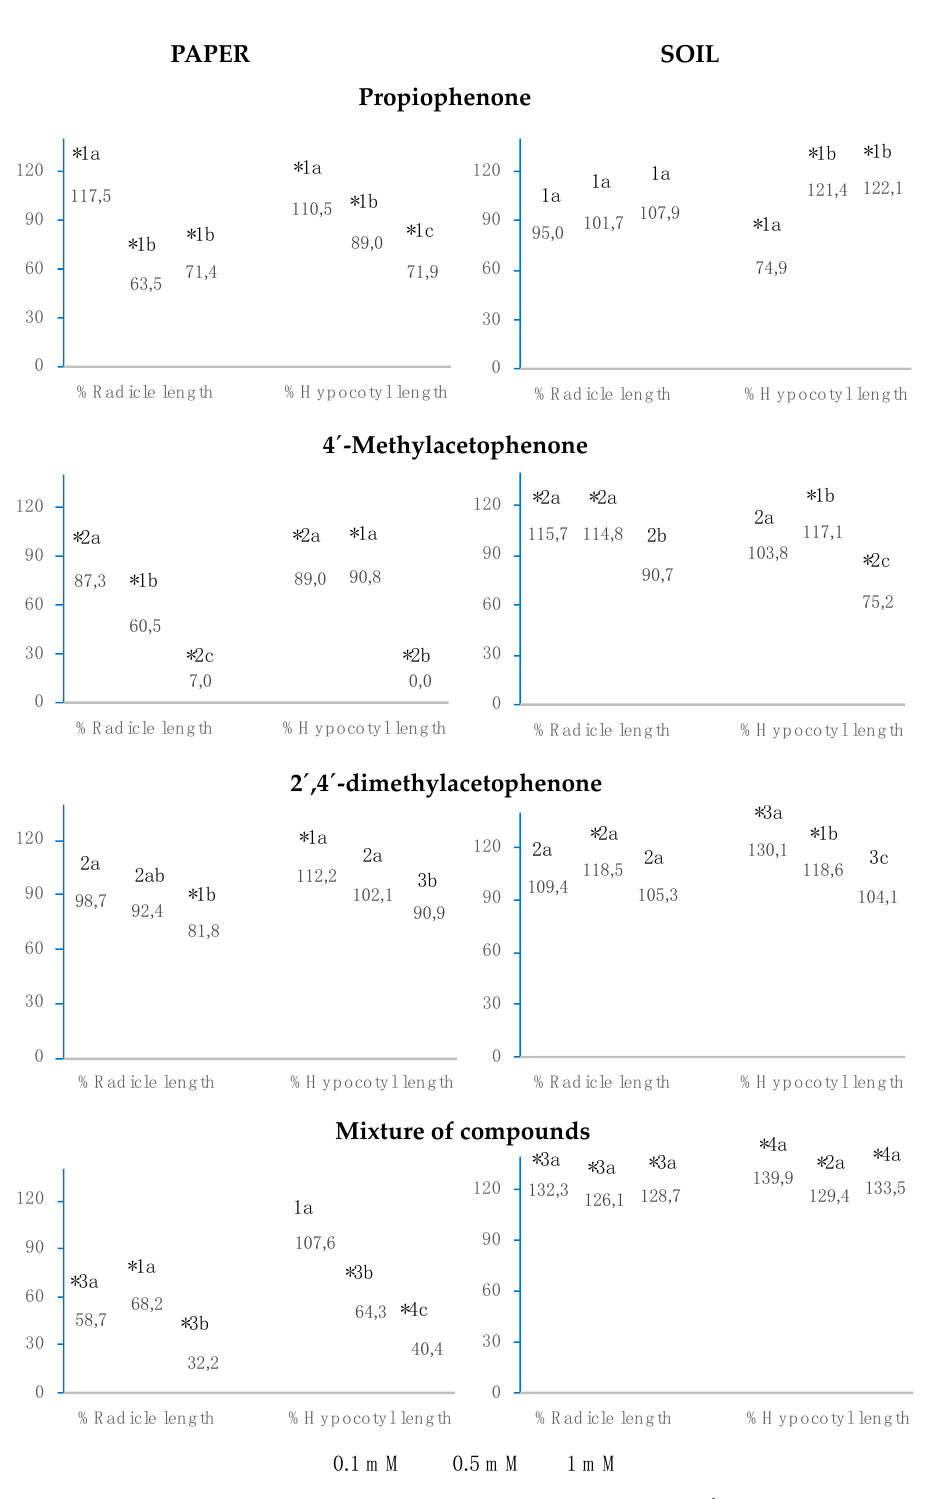
Figure 5. The effect of different concentrations of propiophenone, 4 ′ -methylacetophenone, 2 ′ ,4 ′ -dimethylacetophenone, and the mixture of the three compounds on the radicle and hypocotyl length of Allium cepa , expressed as the percentage relative to the control. Four replicates of each treatment were performed (n = 4 × 50 = 200 seeds in total for each solution). * Significantly different from the controls; 1, 2, 3, and 4: differences numbers indicate significant differences between treatments of the same index and for each concentration. The a, b, c: differences in small letters indicate significant differences between concentrations of the same index and for each treatment. p < 0.05 (Mann–Whitney U test).